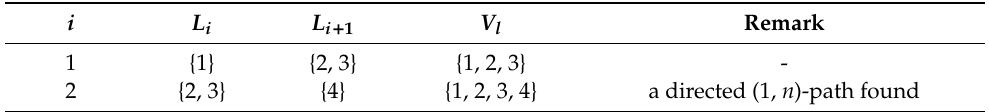
Table 7. Procedure from the PLSA for Figure